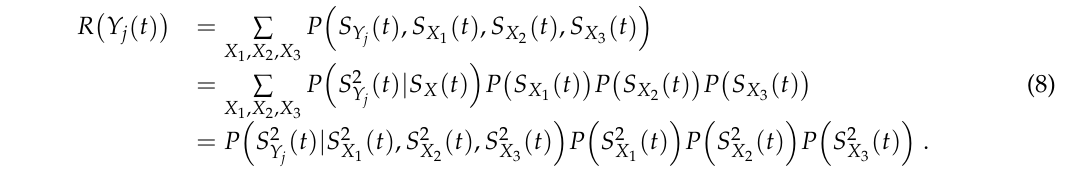
Figure 4. Logical structure in which the parent node is the root node.